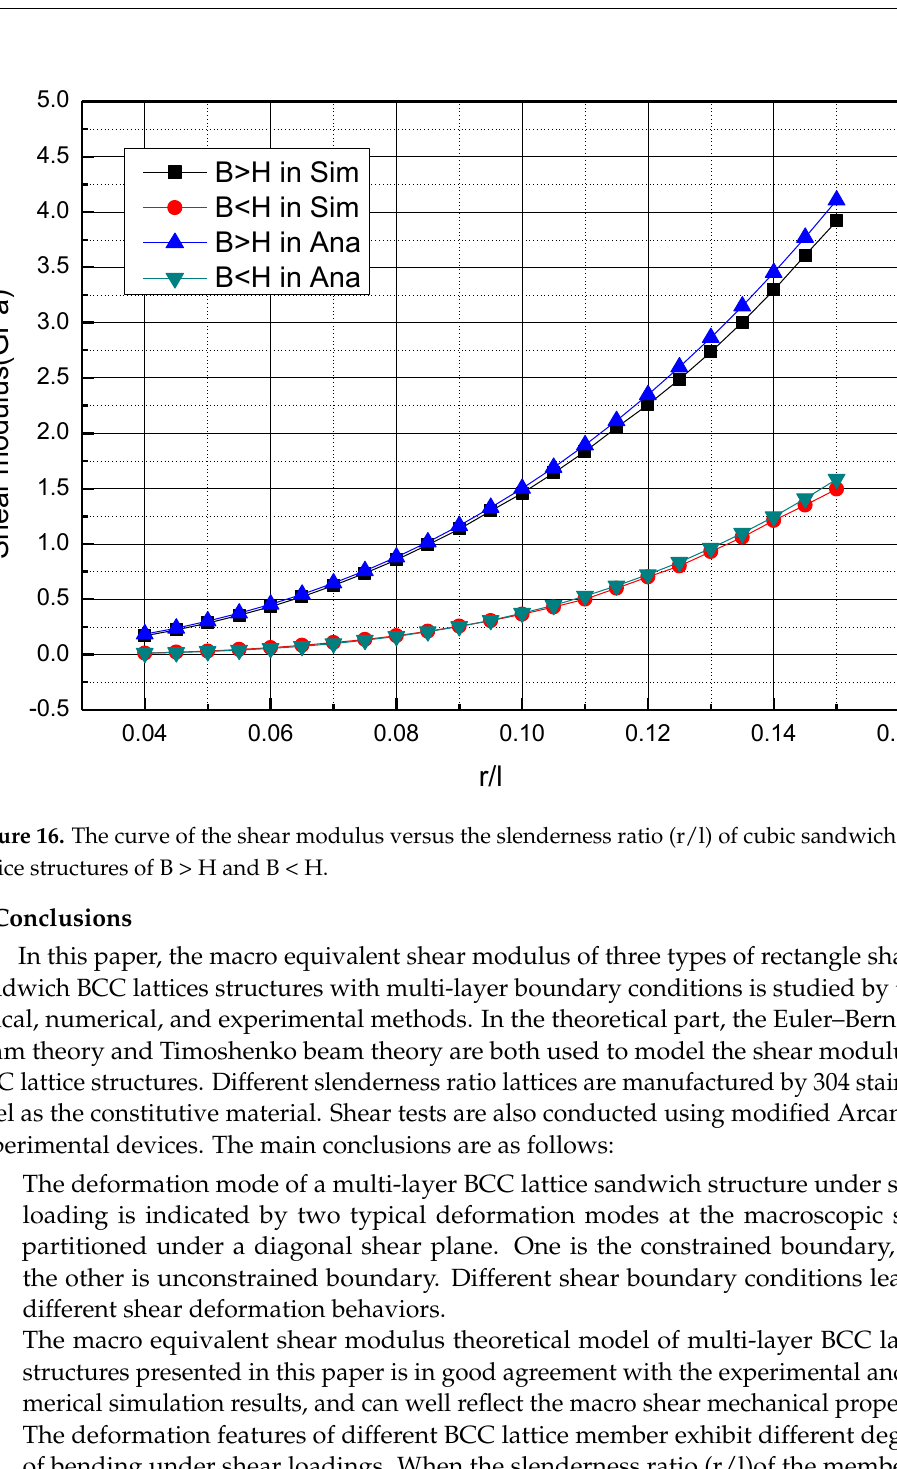
20 of 22 Figure 15. The curve of the shear modulus versus the slenderness ratio (slenderness ratio (r/l) = 0.12~0.2) of cubic sandwich BCC lattice structures. Table 4. Comparison of a multi-layer BCC lattice sandwich structure and equivalent macro shear modulus between experiment, analysis and simulation. No Structure Diameters D/mm